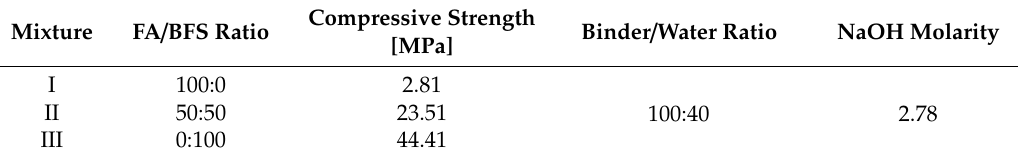
Table 2. Geopolymer mortar compressive strength of, without heat treatment, depending on the fly ash / blast furnace slag ratio [21].